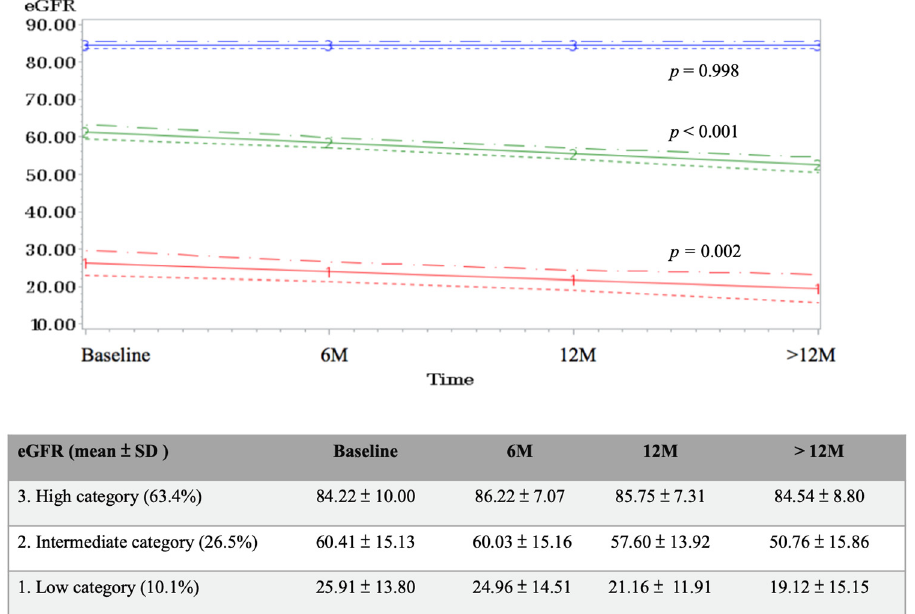
Figure 2. The poststroke renal function trajectory during follow-up. 6 M: 6 months after discharge;